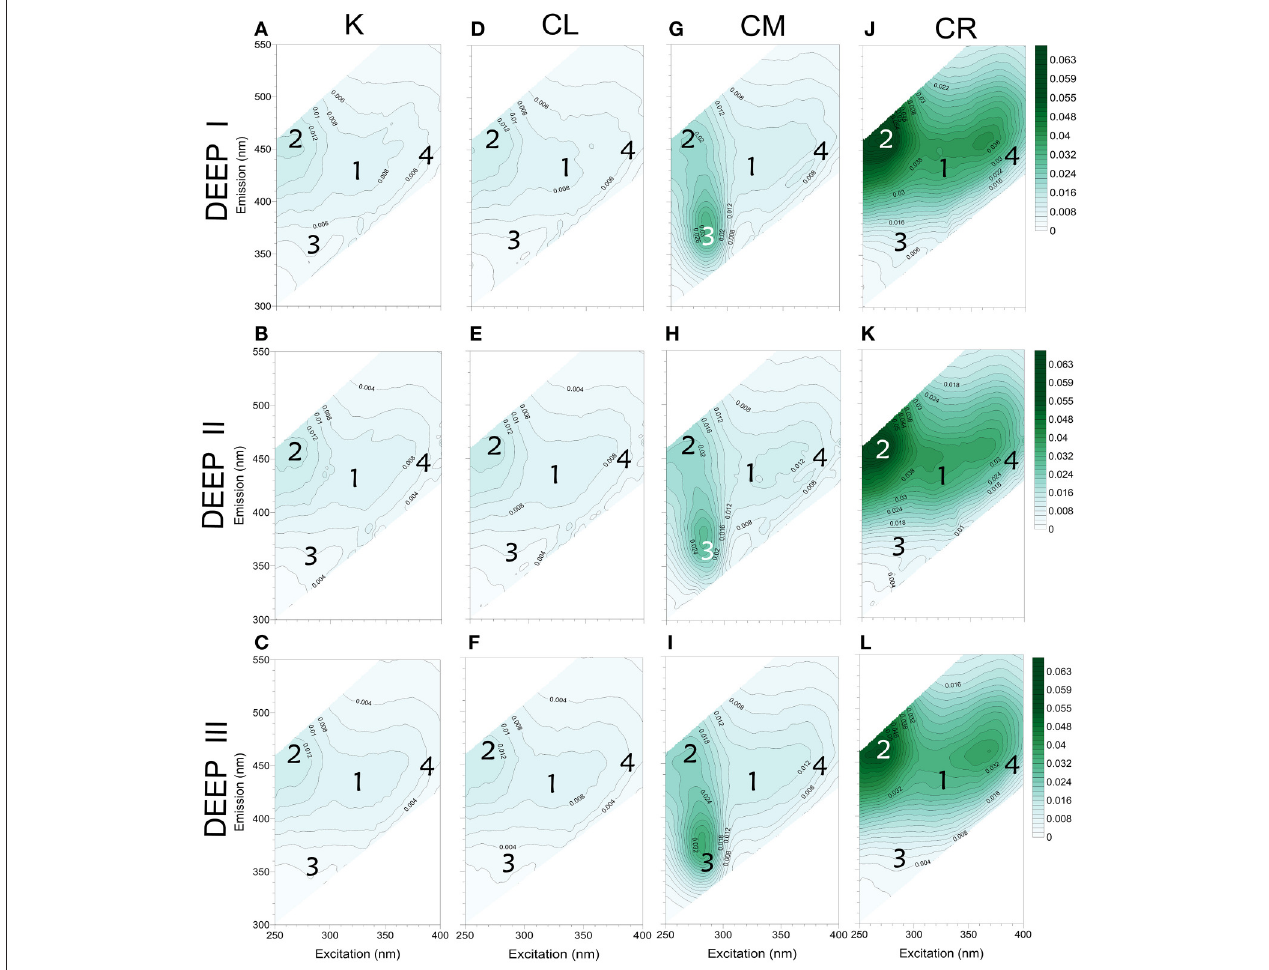
FIGURE 3 | FDOM characterization (EEMs) of all the initial (t0) water samples. From left to right: K conditions for DEEP I (A) , DEEP II (B) and DEEP III (C) ; CL conditions for DEEP I (D) , DEEP II (E) and DEEP III (F) ; CM conditions for DEEP I (G) , DEEP II (H) and DEEP III (I) ; and lastly, CR conditions for DEEP I (J) , DEEP II (K) and DEEP III (L) . Location of the excitation and emission maxima of the four PARAFAC components identified is indicated by the numbers attributed (1, FIC1 Ex/Em: 325nm/423nm; 2, FIC2 Ex/Em: 275nm/468nm; 3, FIC3 Ex/Em: 281nm/363nm; 4, FIC4 Ex/Em: 380nm/428nm). Values expressed in R.U.